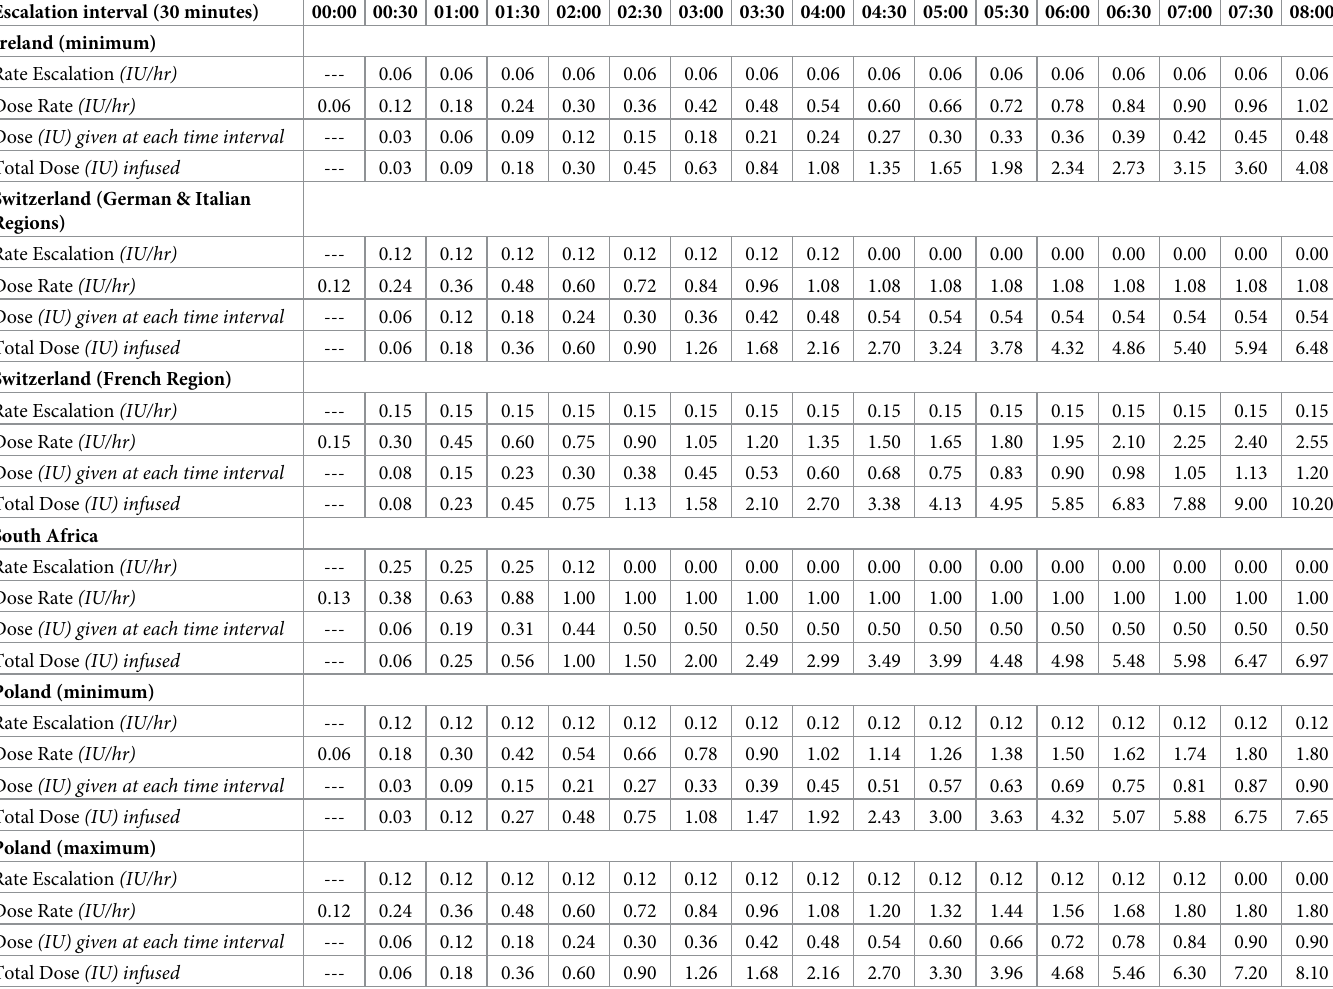
Table 6. Regimens with 30-minute escalation interval. Escalation interval (30